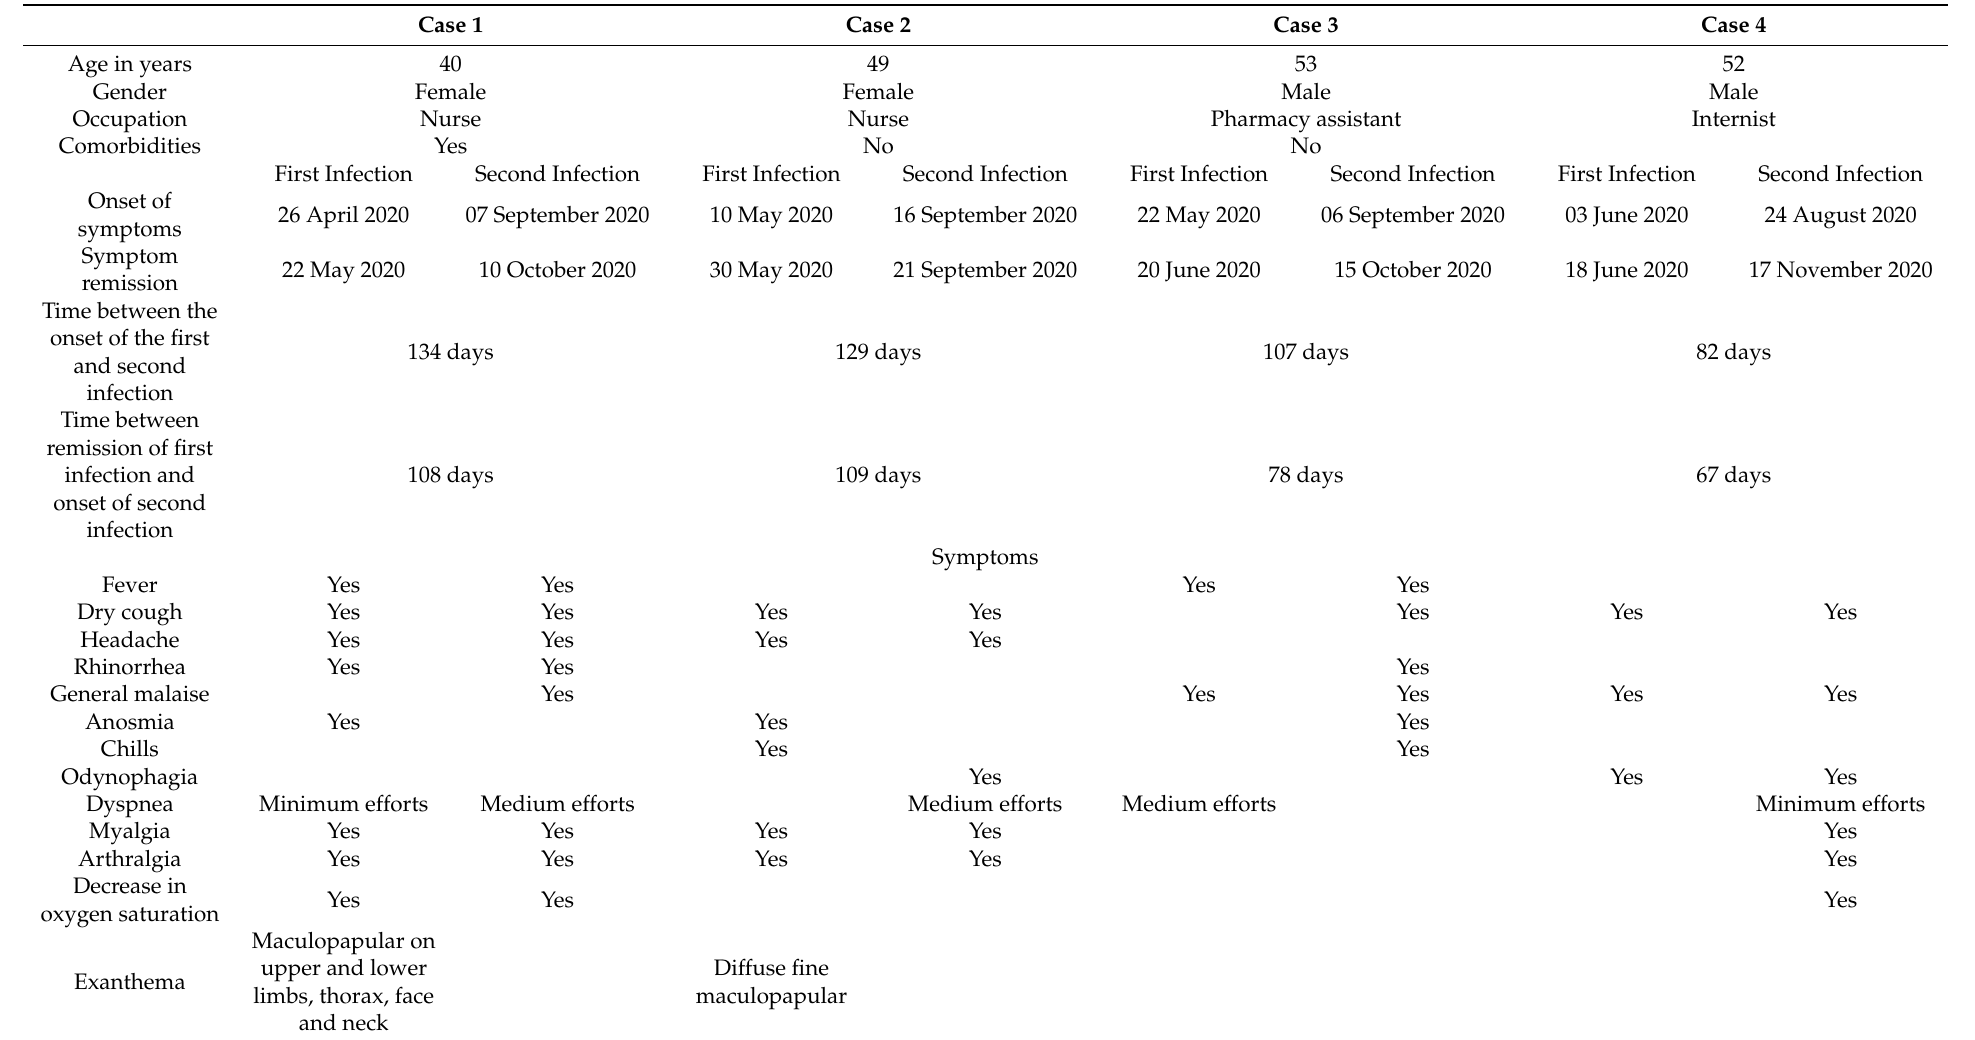
Table 1. Sociodemographic, clinical and treatment characteristics of the four cases analyzed in this